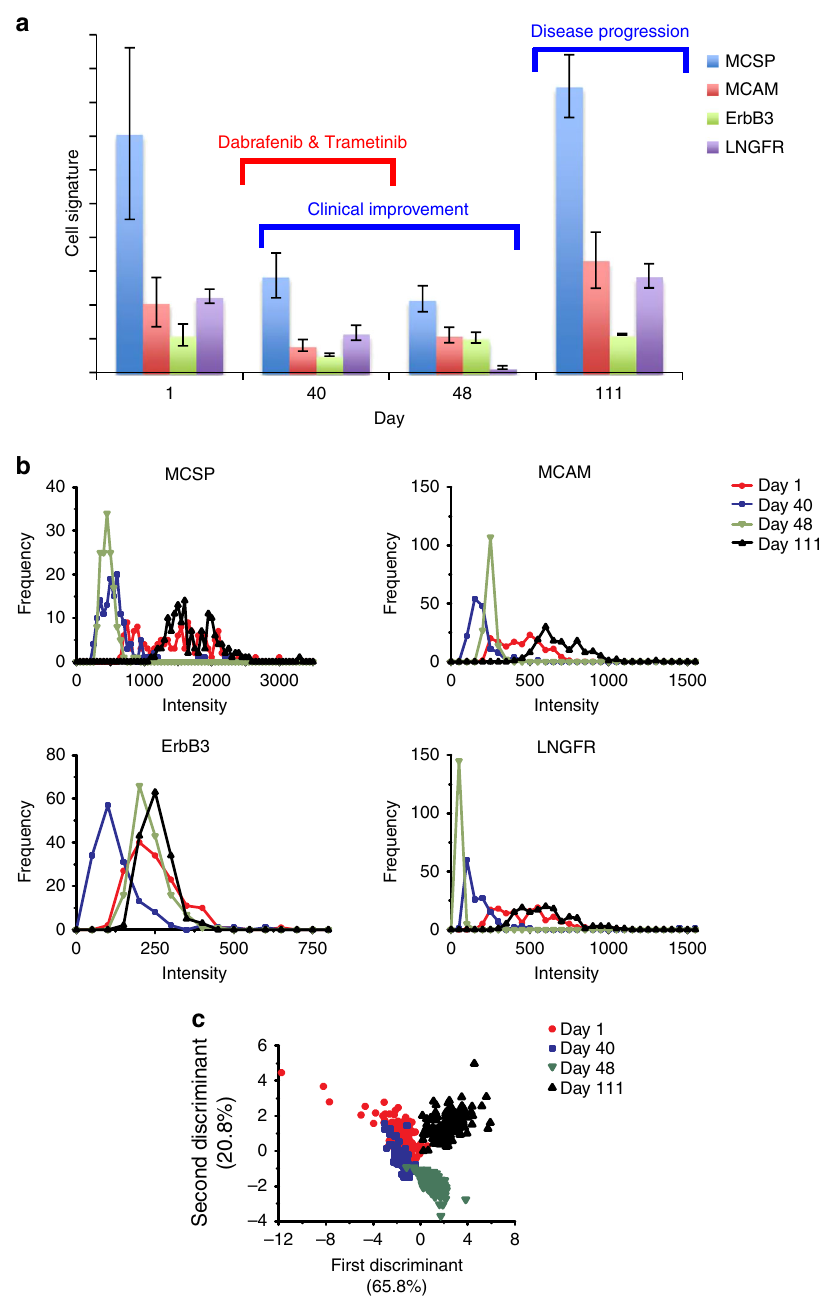
Fig. 4 CTC signatures for patient 1. Patient 1 was treated with dabrafenib and trametinib for 1 month and discontinued because of toxicity. Tumour progressed after cessation of treatment. a CTC signatures presented according to days of treatment. All markers fell initially corresponding to clinical response (day 40). CTC signatures changed signi fi cantly on day 48 in response to treatment with markedly reduced LNGFR level. The signatures returned to pre-treatment pattern upon cessation of treatment, and elevated intensities correlated to disease progression (day 111). b Surface marker expression pro fi le in response to treatment. Signal distribution indicated the tightening of the surface marker expression with treatment and broadening with disease progression. c Clustering of CTC signatures in response to therapy after application of LDA on SERS signals. Data in a are mean ± s.d. with 150 measurements. Each curve in b is calculated by 150 measurements of the bulk of